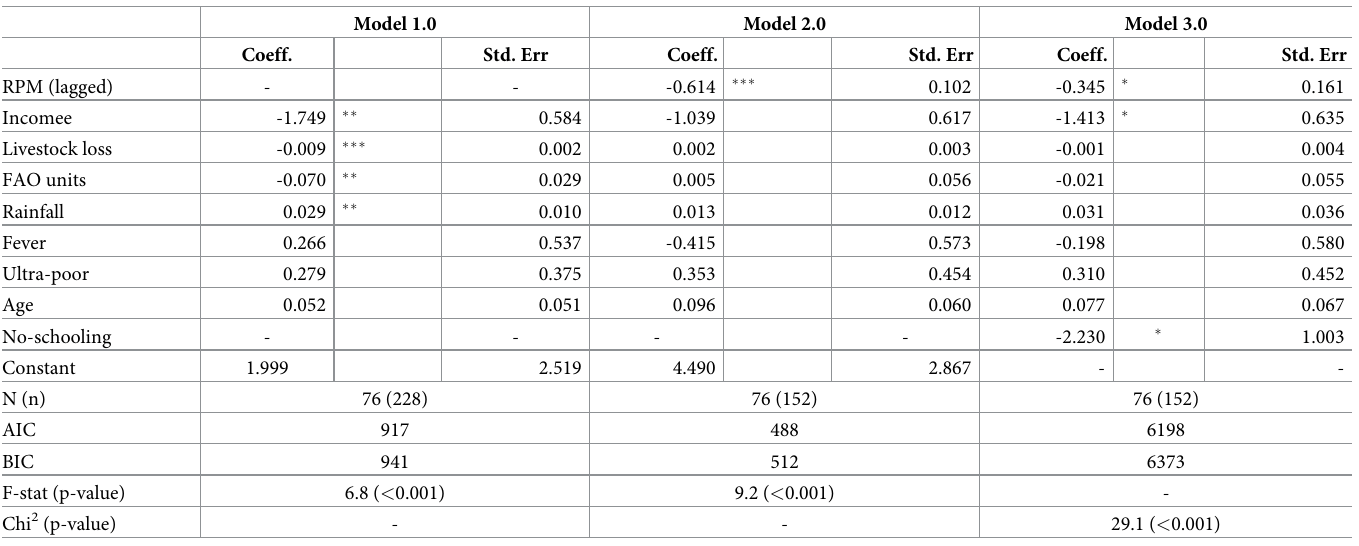
Table 2. Relationship between RPM and